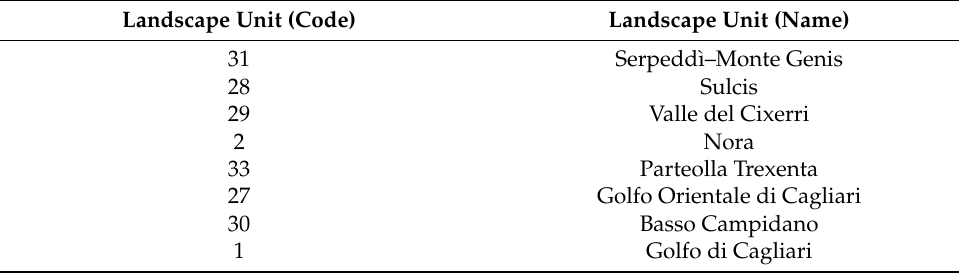
Figure 3. Metropolitan city of Cagliari. ( A ) Natura 2000 sites. ( B ) Areas characterized by different degree of landslide and flood hazard. ( C ) Degree of landscape fragmentation measured by using CILF. The darker the color, the more fragmented the landscape. Table 2. The landscape units included in the MC of